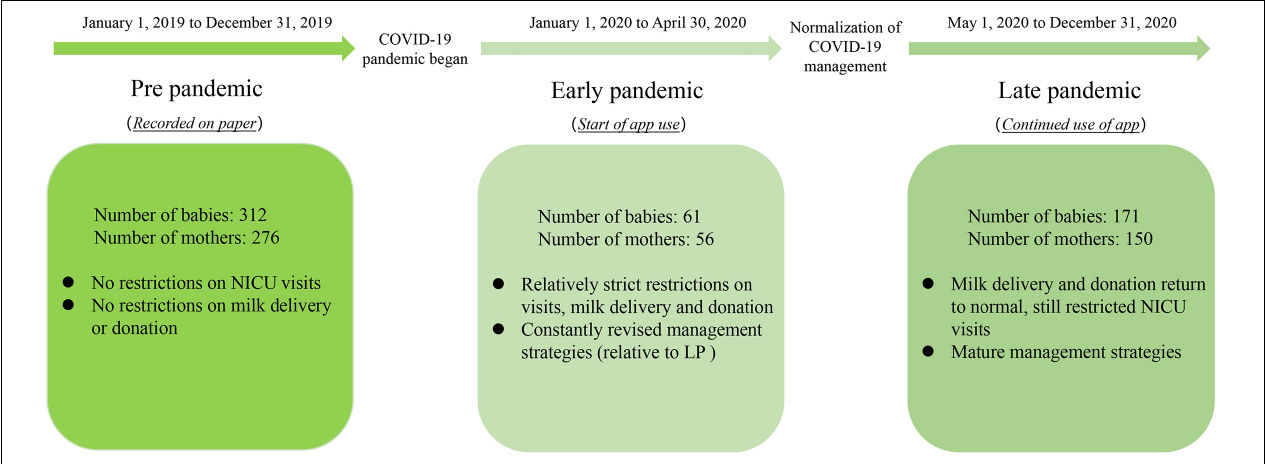
FIGURE 1 | Study timeline related to the COVID-19 pandemic. The boxes contain the number of preterm infants and their mothers enrolled, as well as specific NICU management strategies. NICU, neonatal intensive care unit; LP, late